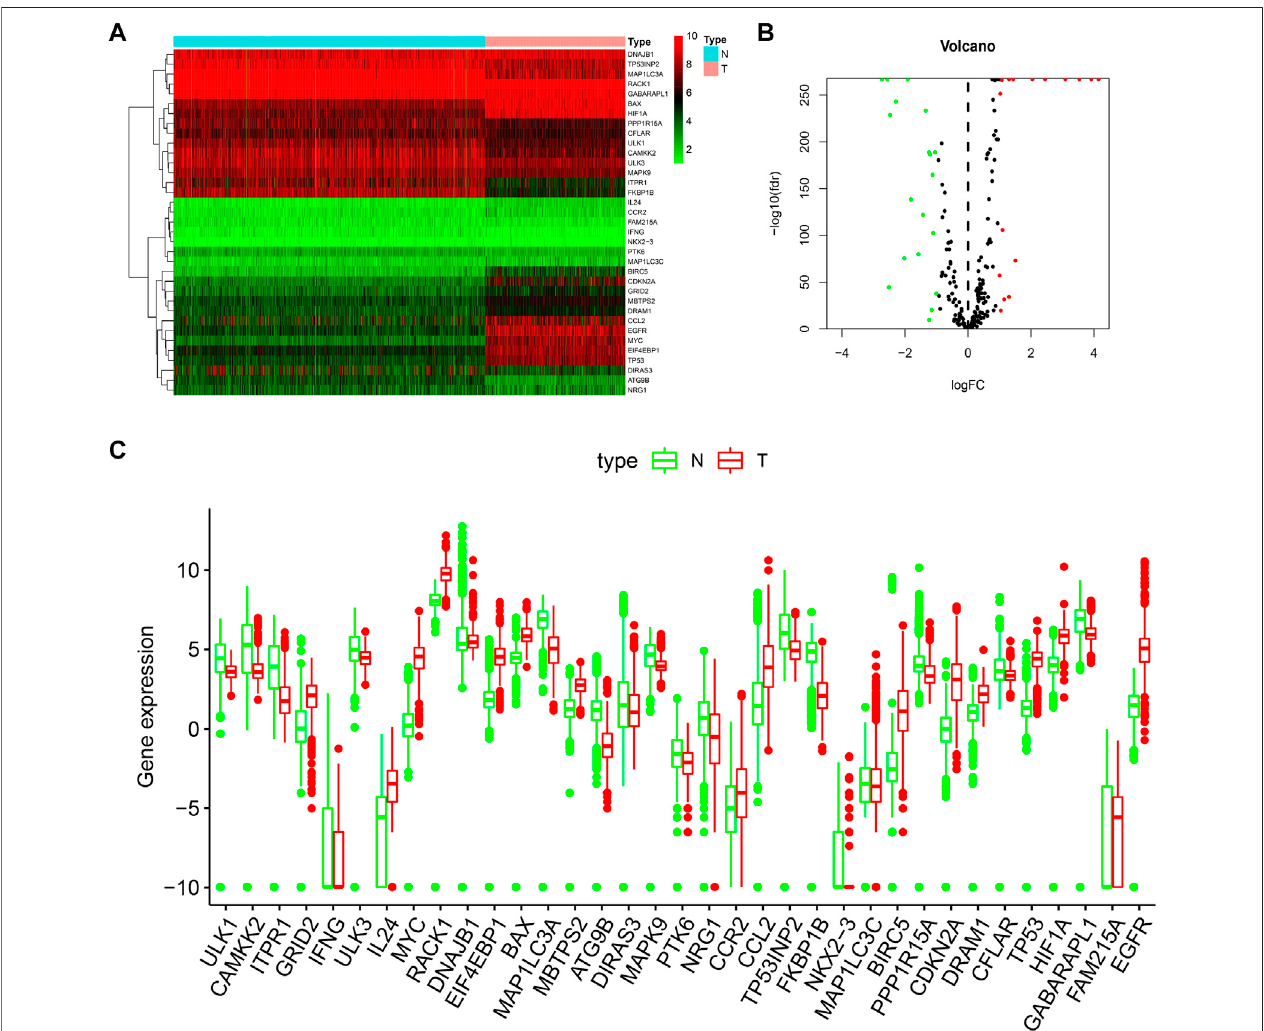
FIGURE1| DistributionsofDE-ARGs. (A) heatmapofDE-ARGs. Greenrepresenteddown-regulated genesand red represented up-regulated genes. (B) volcano plotofSD-ARGs.Greendotsrepresented19down-regulated genes;red dotsrepresented16up-regulatedgenes. (C) box plotofDE-ARGsinnormal braintissuesand tumor brain tissues (all p <